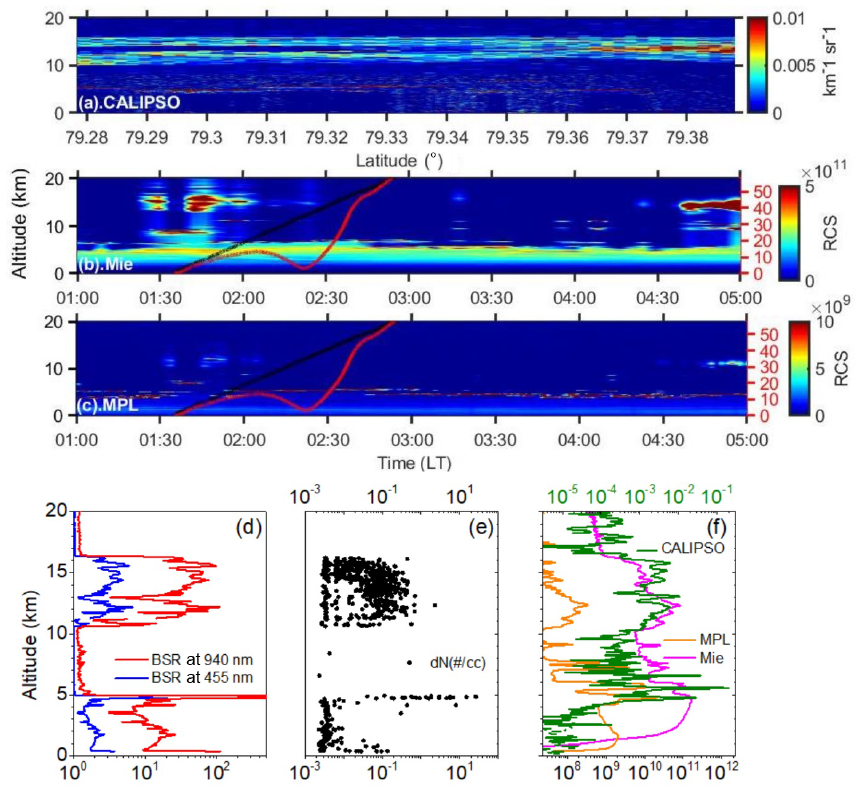
Figure 7. The same as Fig. 6 but for the second pilot campaign (8 July